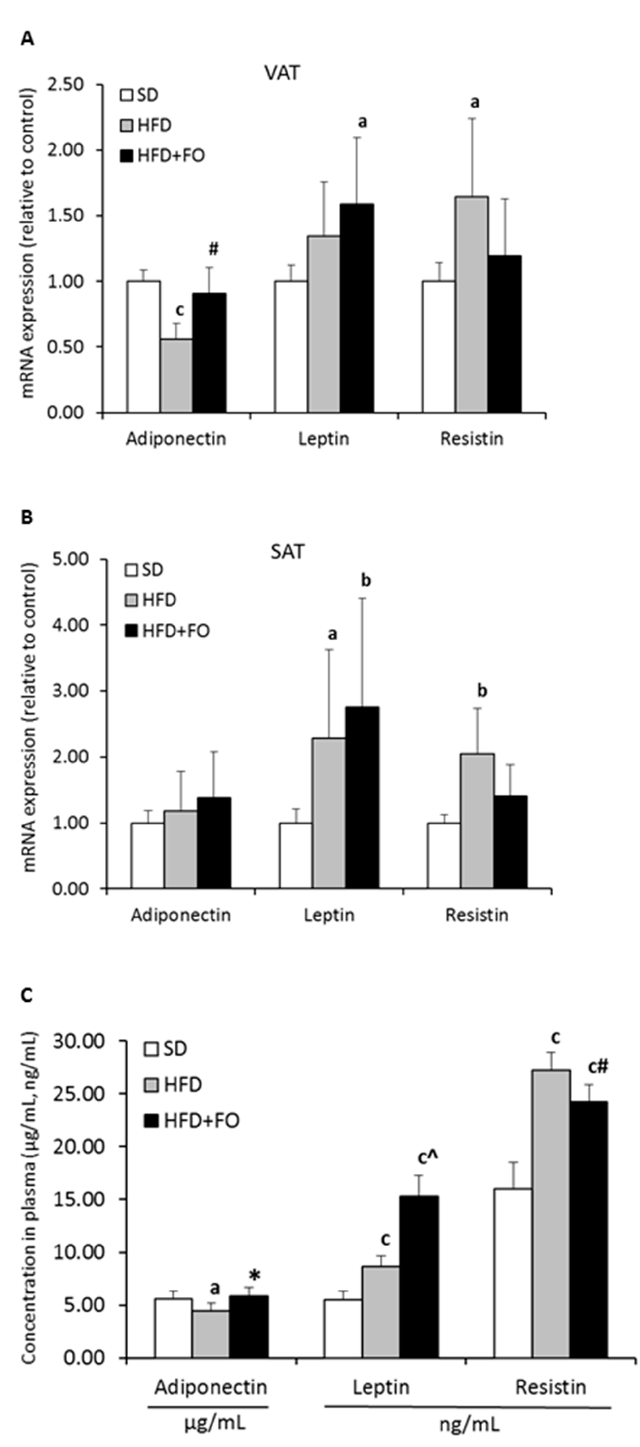
Figure 2. The e ff ect of HFD and HFD + FO consumption on adipocytokines concentration in plasma and mRNA expression in visceral and subcutaneous adipose tissue. Panel A and B present mRNA expression of adipocytokines in VAT and SAT, respectively. Panel C shows, respectively, adiponectin, leptin, and resistin concentration in plasma. Values are expressed as mean ± standard deviation. a p < 0.05; b p < 0.01; c p < 0.001—as compared to SD group. * p < 0.05; # p < 0.01; ˆ p < 0.001—as compared to HFD group, n = 8 per group.